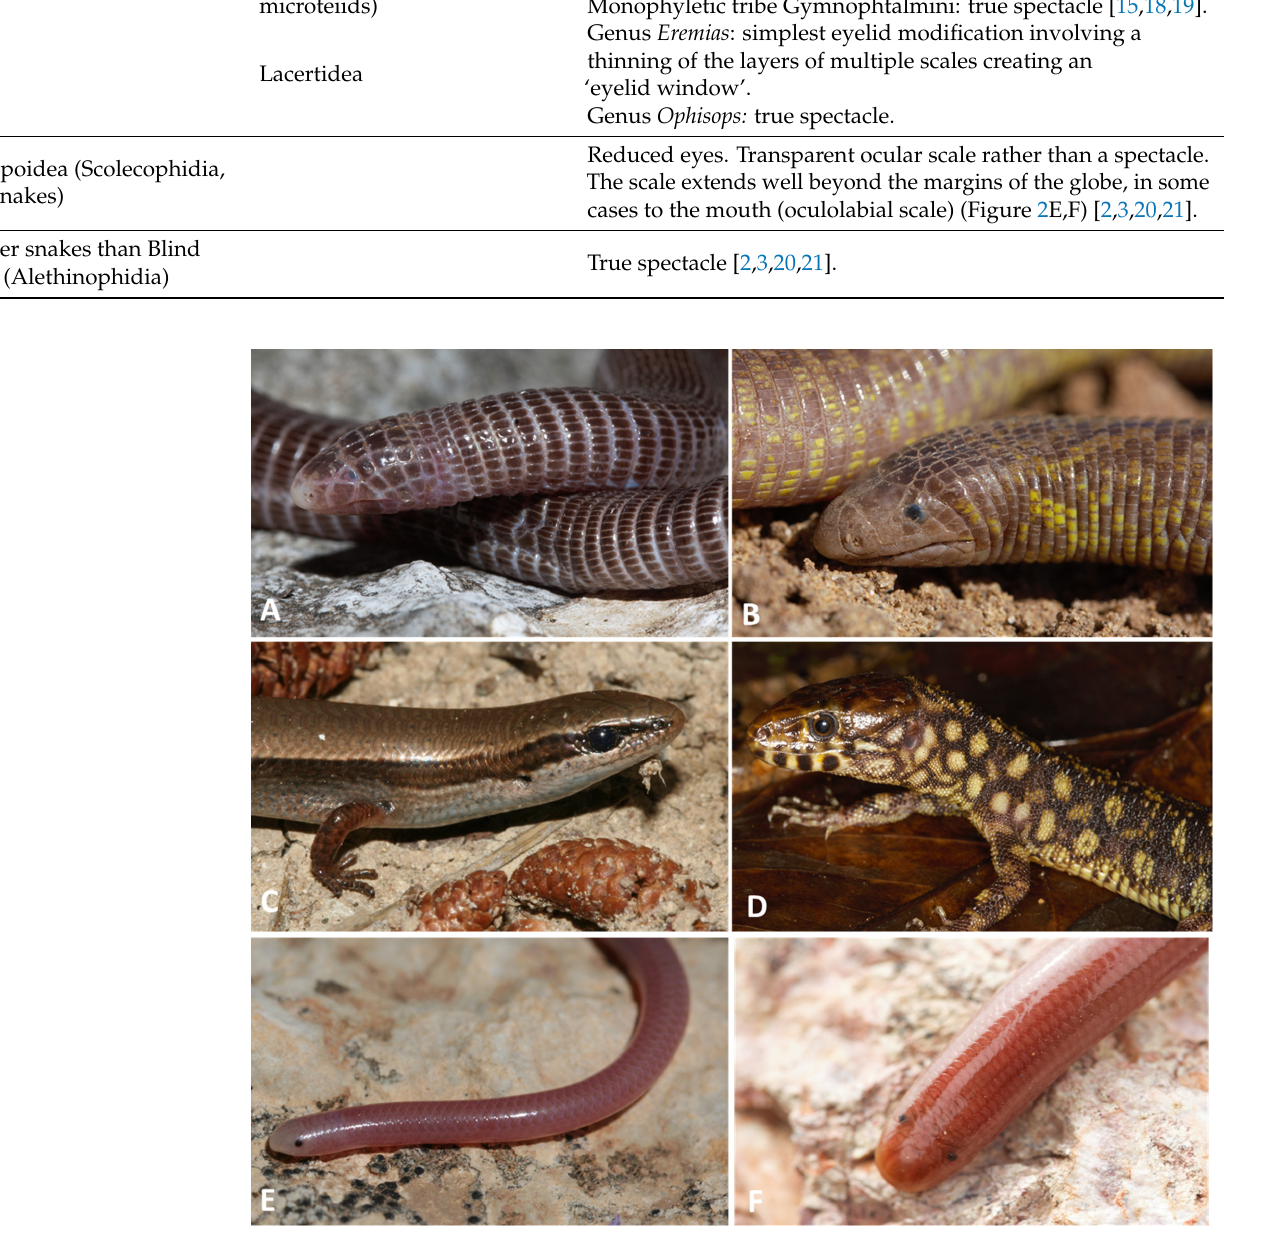
Figure 2. A varying degree of modification of the eyelids is present in several squamata lineages. In worm lizards (Amphisbaenia), such as the Turkish worm lizard ( Blanus strauchi ) ( A ) and the check- erboard worm lizard ( Trogonophis wiemanni ) ( B ), reduced eyes are covered by an ocular scale. ( C ) The Budak’s snake-eyed skink ( Ablepharus budaki ) and other members of its genus have a true spec- tacle and are the only known reptile species that possess a lacrimal gland. ( D ) In all members of the family Xantusiidae, such as the Costa Rican tropical night lizard ( Lepidophyma reticulatum ), movea- ble eyelids have been replaced by a true spectacle. Ocular scales that extend well beyond the mar- gins of the globe are present in blind snakes such as the long-nosed worm snake ( Myriopholis macrorhyncha ) ( E ) and the Eurasian blind snake ( Xerotyphlops vermicularis ) ( F ). ©Frank Pasmans. Outside of the squamata, modification of the eyelids is only seen in a few turtle spe- cies (e.g., the Indian flapshell turtle ( Lissemys punctata ) and the eastern long-necked turtle